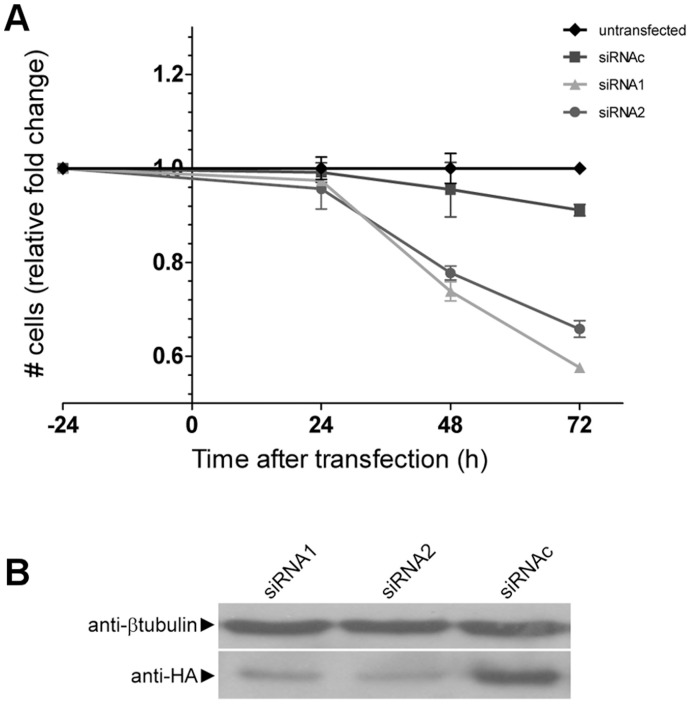
MXD3 knock-down decreases DAOY medulloblastoma cell proliferation.(A) Loss of MXD3 decreases DAOY cell proliferation. Quantification of cell proliferation (as total number of cells relative to control) of DAOY cells transfected with MXD3 (siRNA1, 2) or control (siRNAc) siRNAs. Knock-down of endogenous MXD3 resulted in reduced DAOY cell counts (asterisks, p<0.05; n  = 3; two-way ANOVA). (B) siRNA-mediated reduction of HA-MXD3 expression. DAOY cells were transiently co-transfected with HA-MXD3 and siRNAs as in (A). Extracts were probed with anti-HA antibody to detect HA-MXD3 (lower panel) or anti-tubulin antibodies for load control (upper panel).